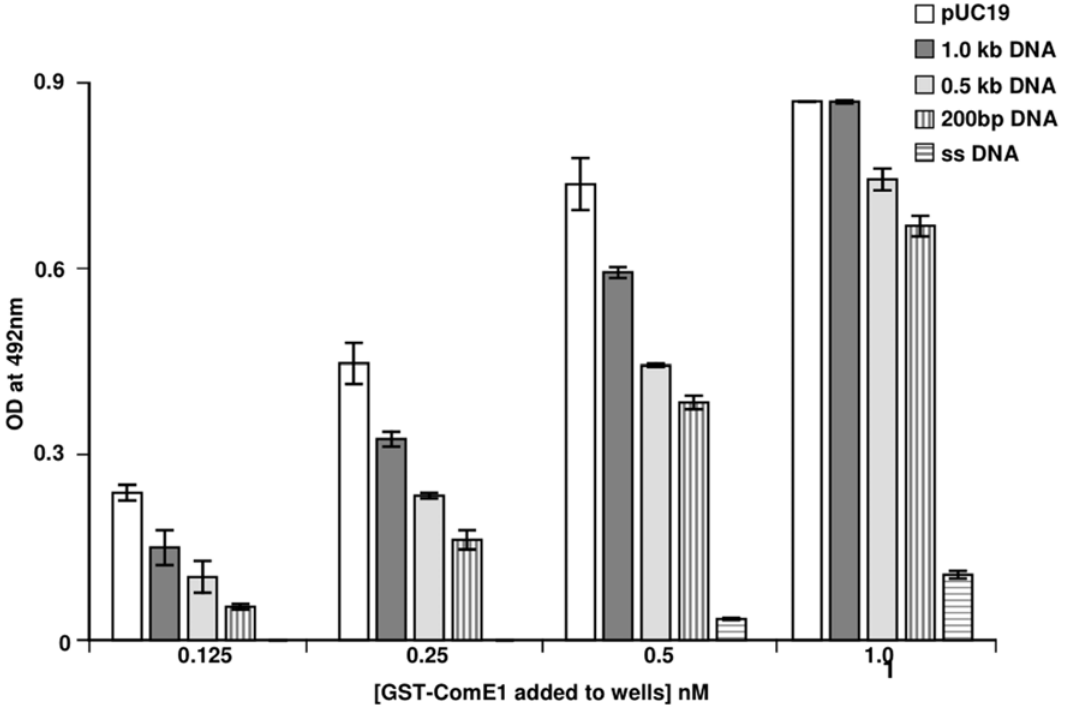
Figure 3. Binding of ComE1 to single-stranded DNA. Binding of 1 nM of recombinant GST-ComE1 from P. multocida to immobilised DNA fragments or single-stranded DNA (ssDNA) measured by direct binding ELISA. The data are presented as the mean 6 SEM of triplicate wells. The data shown are representative of three separate experiments.